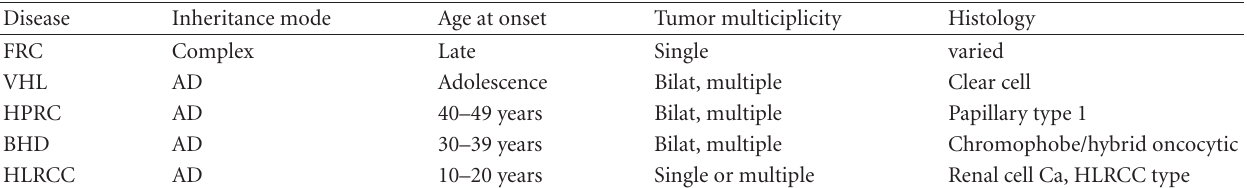
Table 4: FRC versus autosomal dominant (AD) forms of kidney cancer (adapted from Zbar et al. [3]).